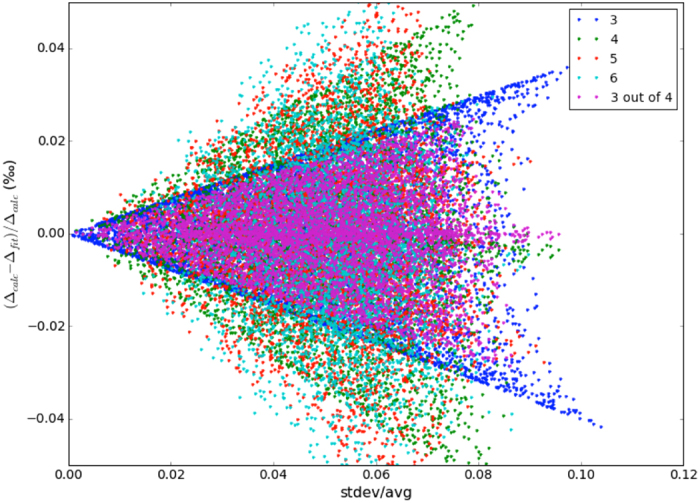
Difference between the analytical curves shown as black lines in Fig. 6 and the calculated value of Δ for the randomly generated sets of isotope ratios (colored points in Fig. 6).For each multi-isotope system, the outer envelope of the points gives the error within which the apparent statistical isotope clumping can be predicted for a certain set of isotope ratios when the relative standard deviation (stdev/average) of the isotope ratios of the indistinguishable atoms is known.